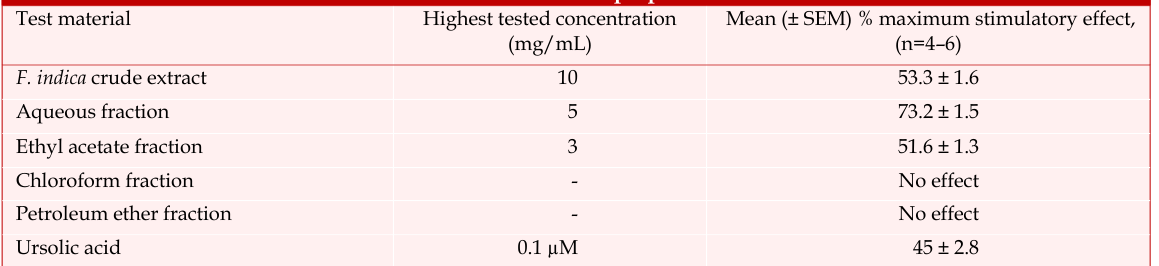
Maximum stimulatory effects of crude extract and fractions of F. indica at highest tested concentration in isolated rat s ileum preparation Test